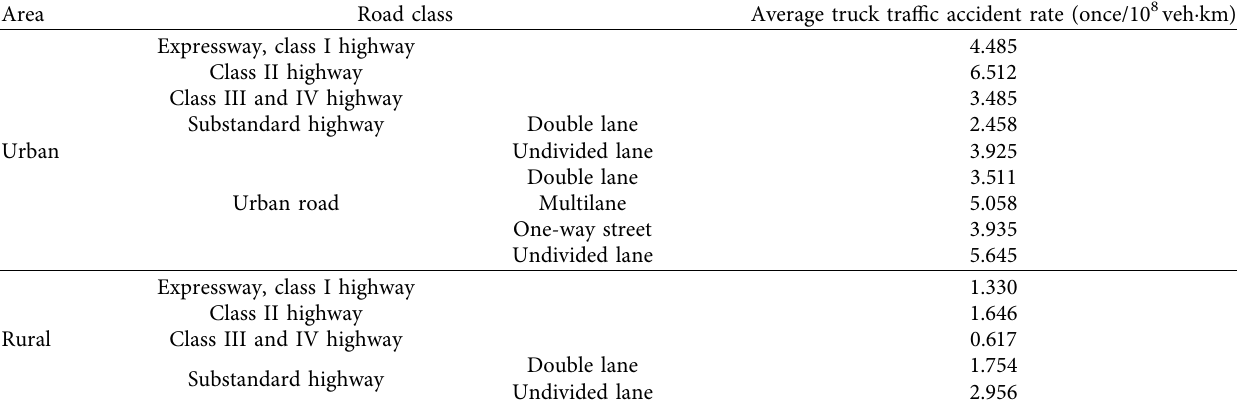
Table 1: Basic traffic accident rate of dangerous goods transportation.